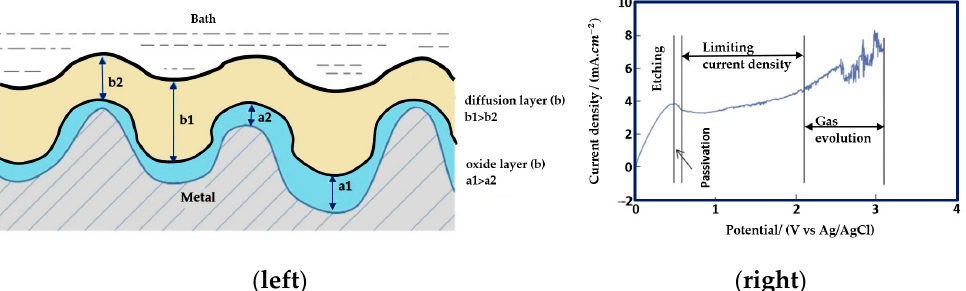
Figure 3. ( left ) Initial oxide and a diffusion layer on the metal surface [9], ( right ) Typical current– voltage characterisation curve (I–V) for electropolishing (four regions of etching, passivation, limiting current density, and gas evolution [46]. (Open access article distributed under the terms and conditions of the Creative Commons Attribution (CC BY) license).